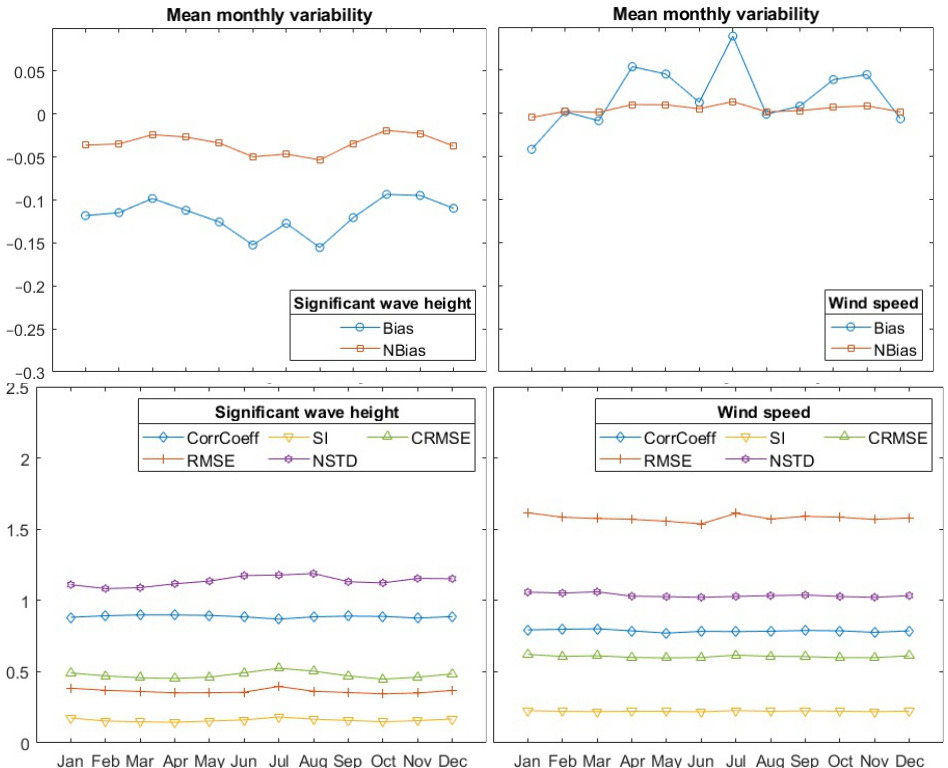
Figure 8. Mean monthly variability of error measures between the two reanalyses ( left : significant wave height, right : wind speed).